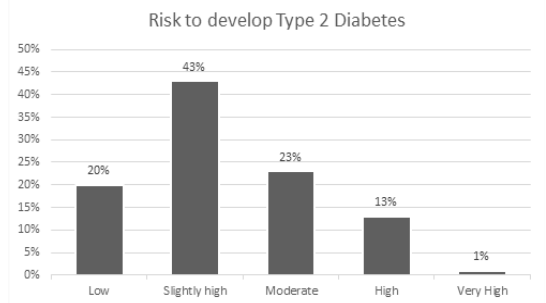
Figure 5. Stratification of the risk of having type 2 diabetes melli- tus in 10 years in physicians from 40 to 60 years